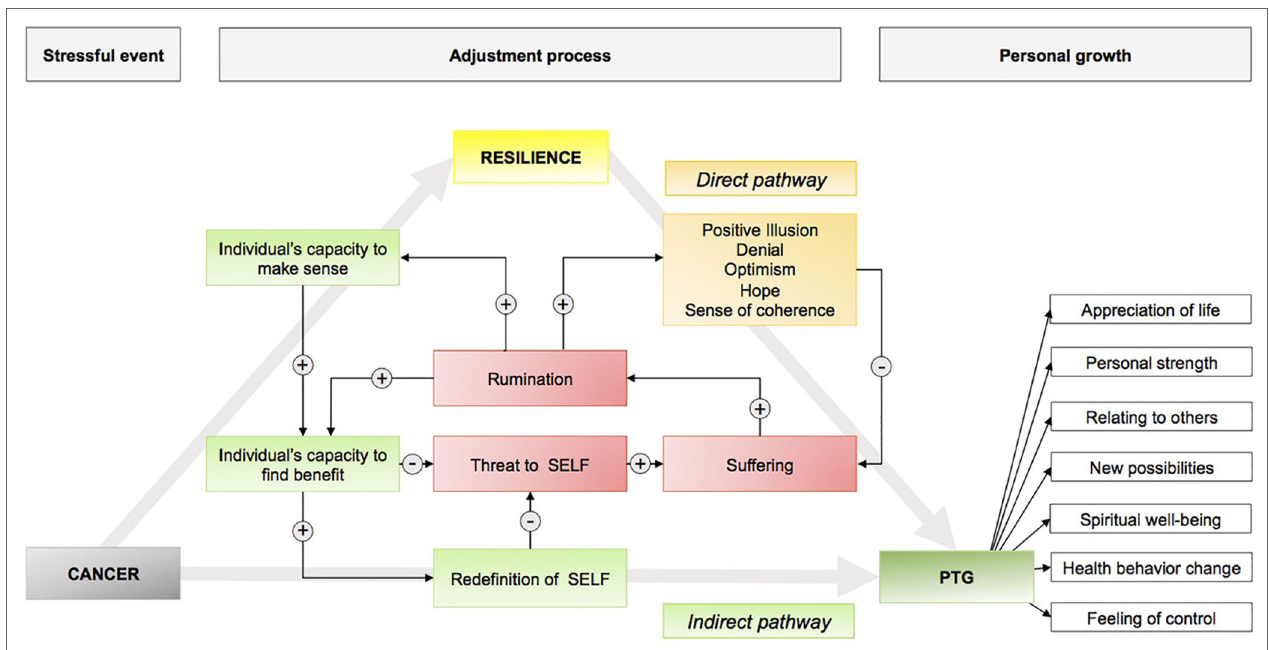
FIGURE 1 | Conceptual framework of resilience, meaning making, and posttraumatic growth following a cancer diagnosis. Two different pathways of resilience are presented: direct pathway (orange) buffers distress and suffering via personality traits and coping abilities; the indirect pathway (75) decreases suffering by changes and redefinition of the individual’s self. Note: (+): increase; (−):